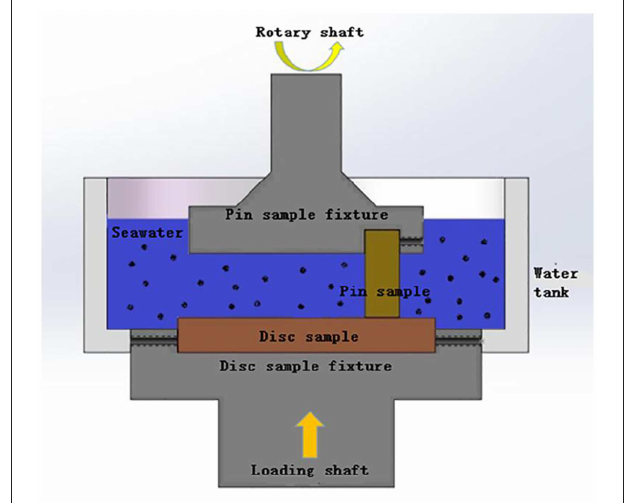
FIGURE 1 | Schematic diagram of the configuration for pin-on-disc tribometer.